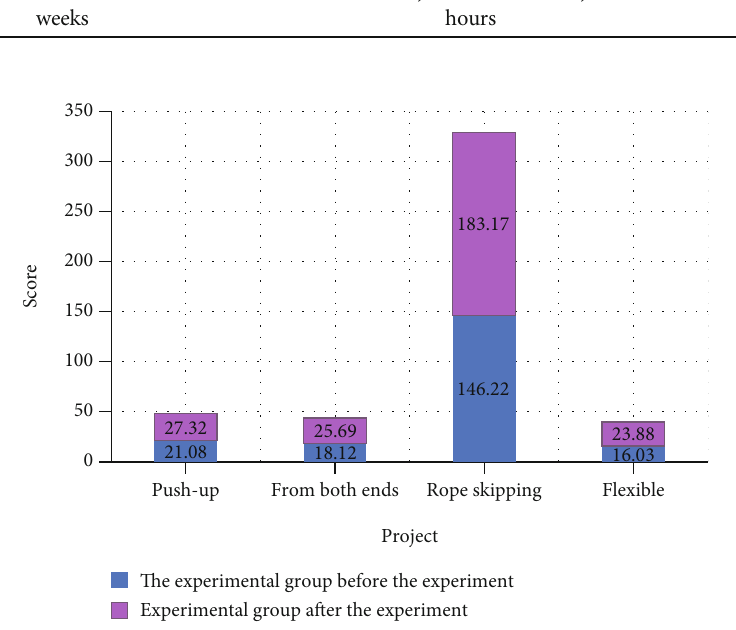
Figure 1: Physical fi tness statistics of experimental group.